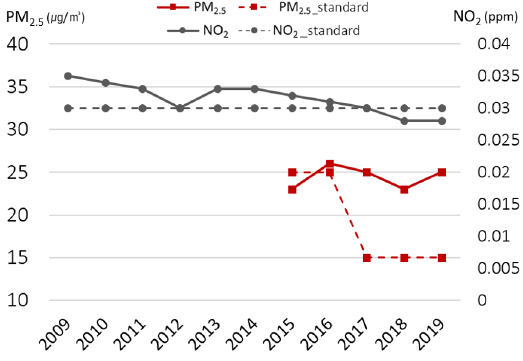
Figure 3. Concentrations of NO 2 and PM 2.5 .